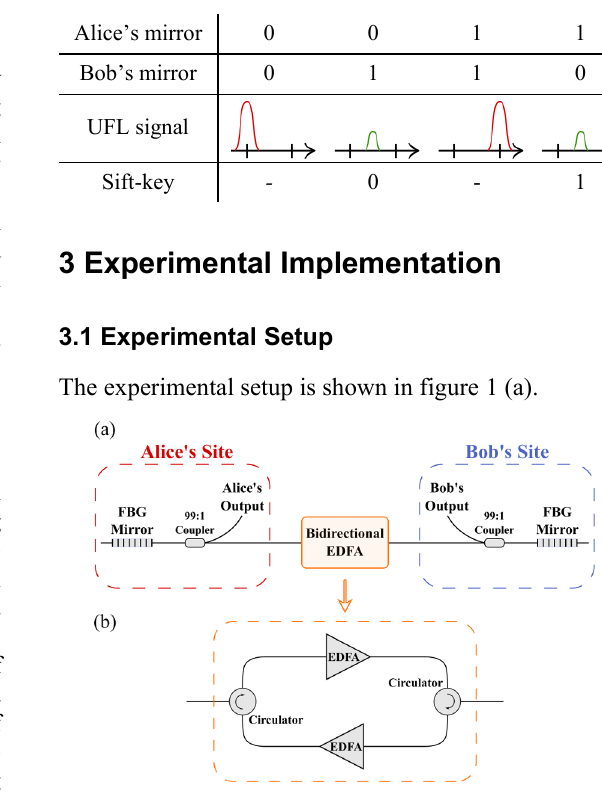
Fig. 1. (a) Lab setup and (b) internal schematic of the bidirectional EDFA